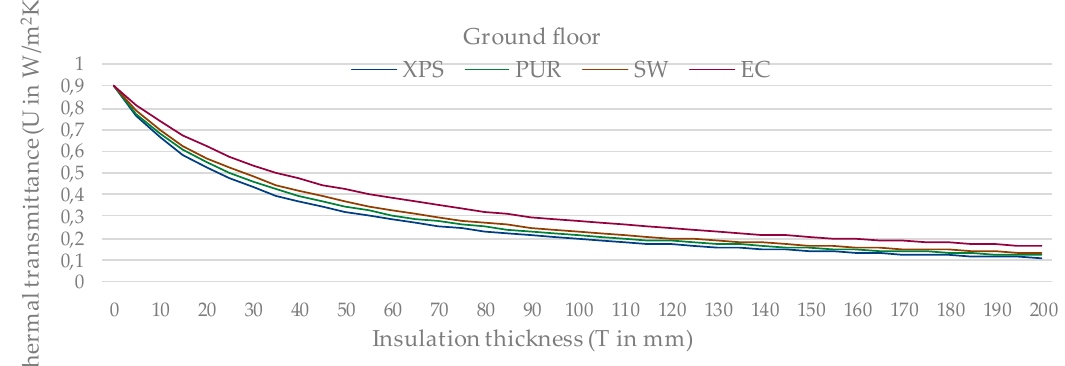
Energies 2019 , 12 , x FOR PEER REVIEW Figure A8. Thermal transmittance (U-value) according to insulation thickness, for ground floor.